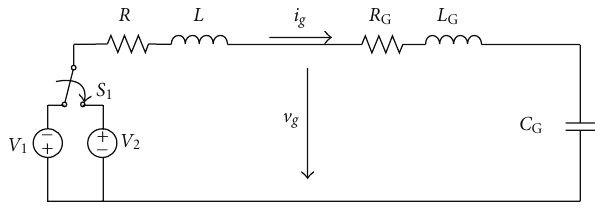
Figure 6: A simplified gate-drive circuit of an